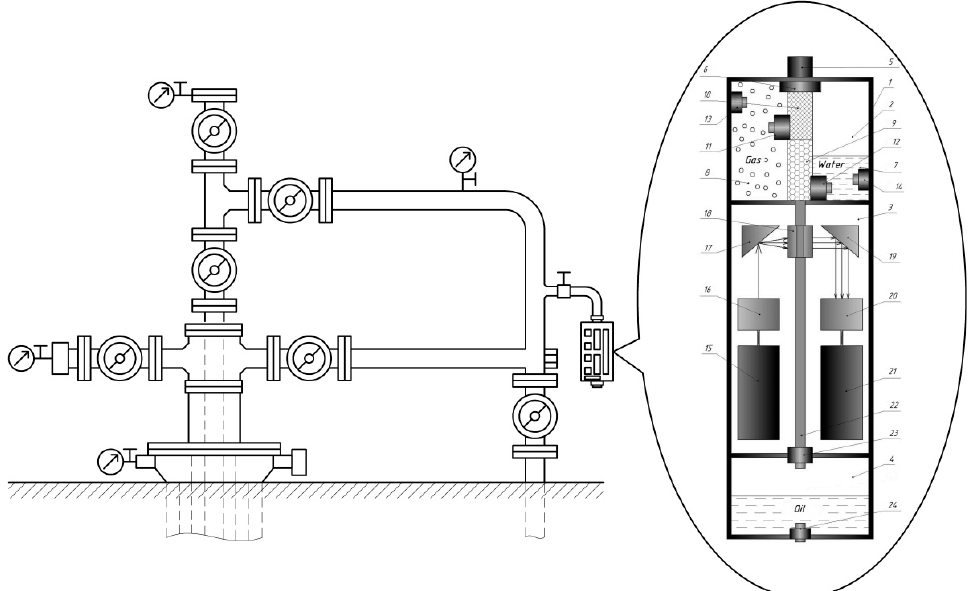
Figure 11. Mobile device for measuring optical oil properties. 1—heat-resistant housing block;